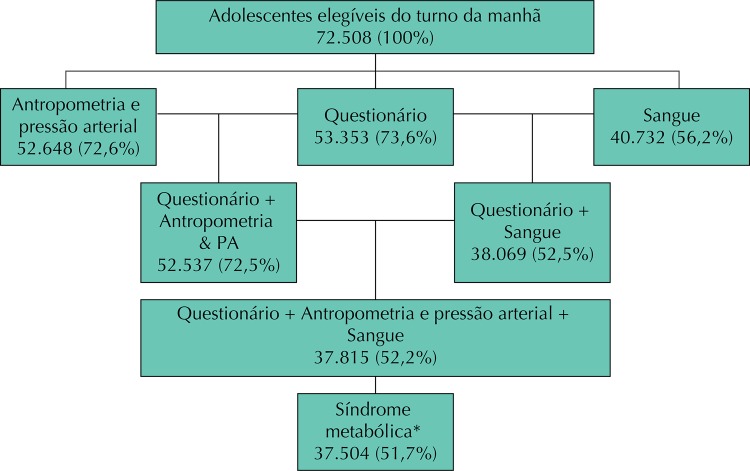
Fluxograma dos participantes avaliados quanto à prevalência de síndrome metabólica. ERICA, Brasil, 2013-2014.* 311 adolescentes não tiveram resultados de todos os exames necessários para diagnóstico da síndrome metabólica.